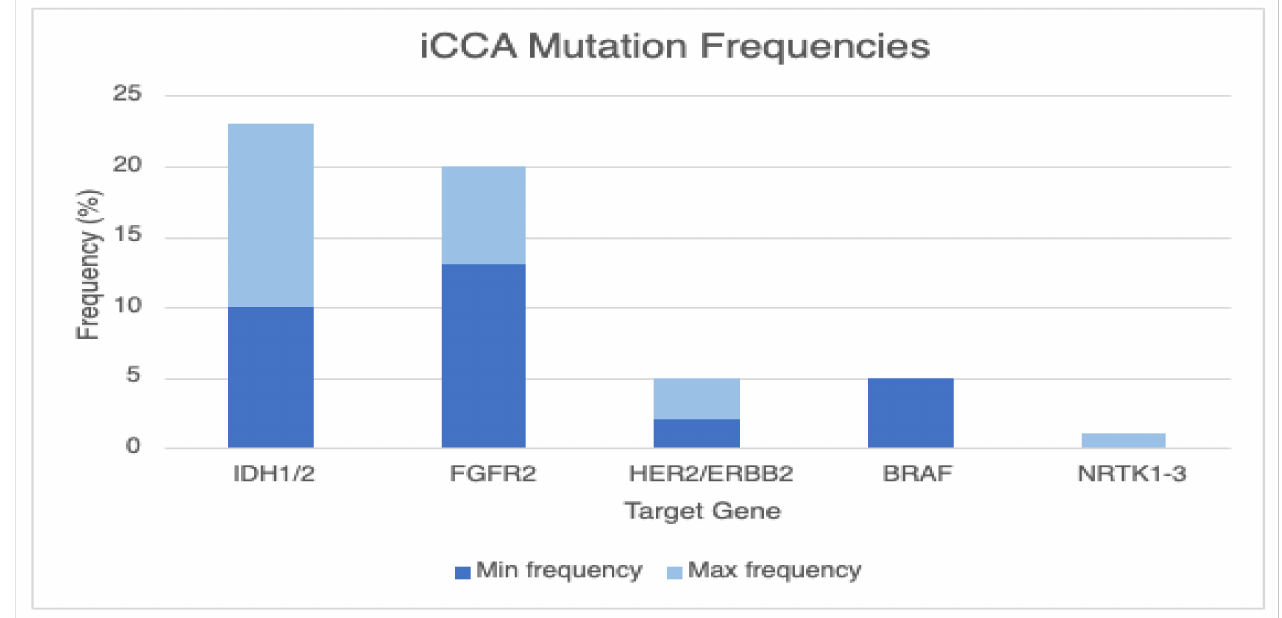
Figure 1. Mutation frequencies in iCCA. From the most common to the least common, ranges of frequencies of targetable mutations in Isocitrate dehydrogenase ( IDH ) 1/2, fibroblast growth factor receptor ( FGFR )2, HER2 /ERBB2, B-raf kinase ( BRAF ), and neurotrophic receptor tyrosine kinase (NRTK) 1-3 are